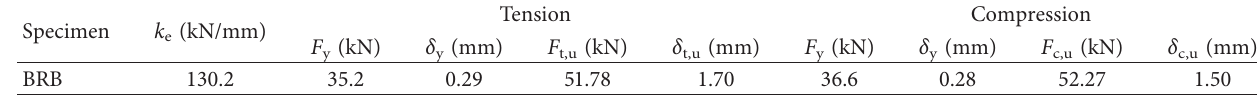
Table 7: Mechanical parameters of the BRB.